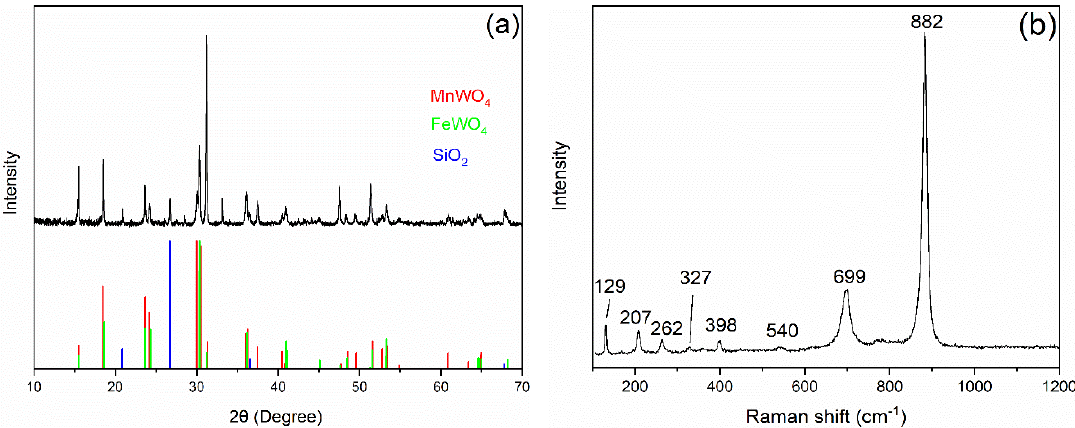
Figure 3. Powder XRD patterns ( a ) and Raman spectrum of natural wolframite ( b ).